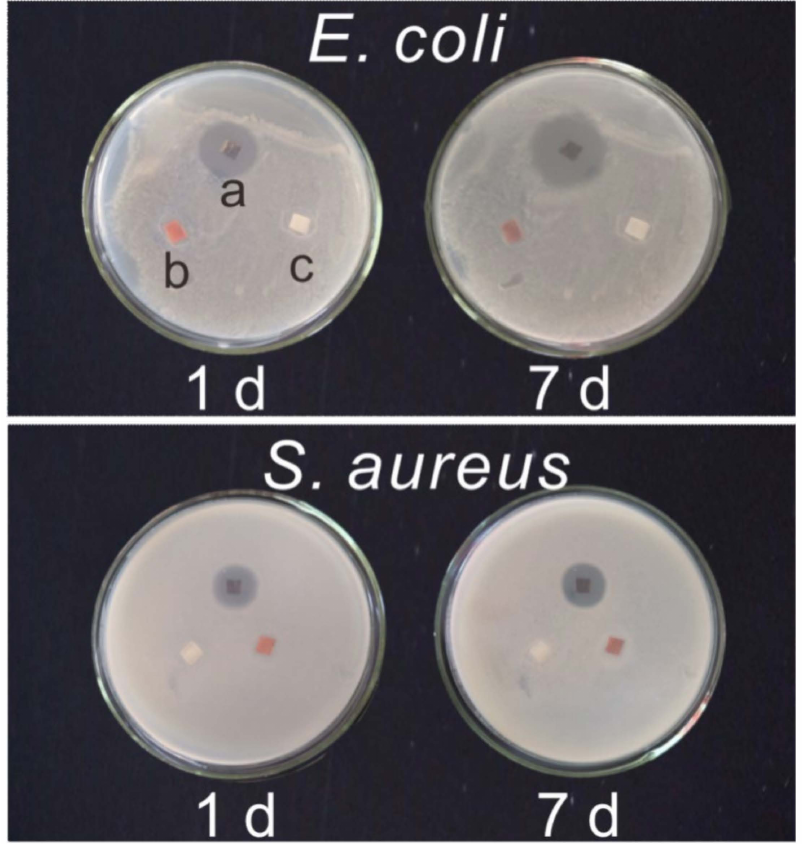
Figure 2. Inhibition zone test of the as-made Ni-PW (a), PEI-PW (b), and PW (c) against E. coli and S. aureus .